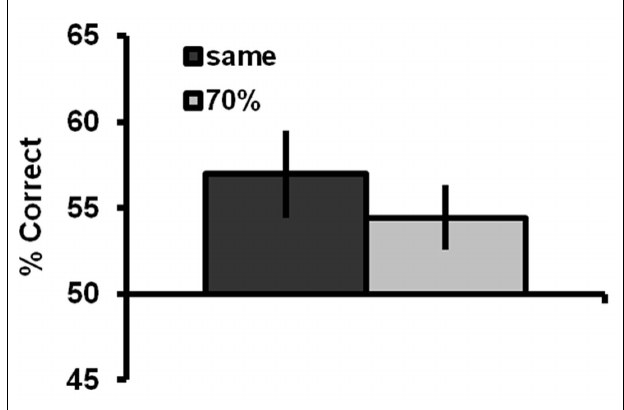
FIGURE 3 | Correct responses (as %, ± 1 SEM) for experiments 1A (same-sized probe) and 1B (70% sized probe).